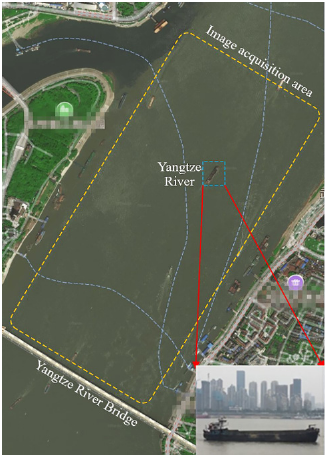
Figure 12. Scene diagram of the image-acquisition area.